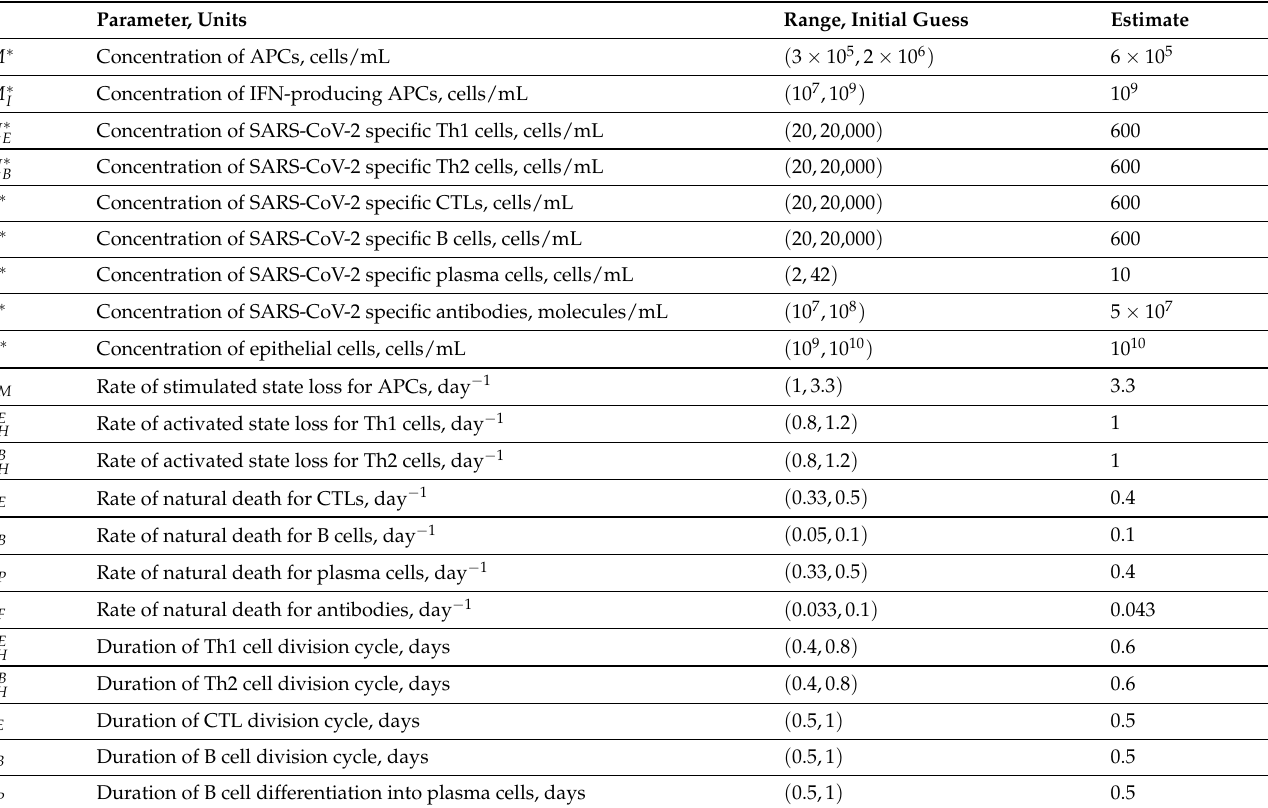
Table 1. Parameters of the calibrated